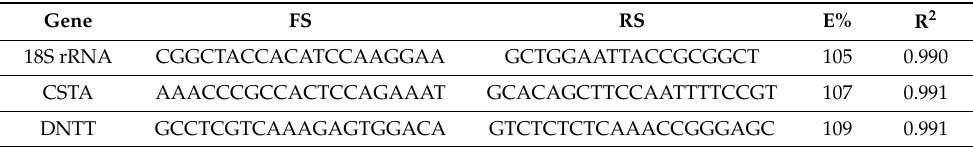
Table 1. Gene names, forward (FS) and reverse (RS) primer sequences, PCR efficiency (E%) and R 2 value for the target genes and the reference gene 18S